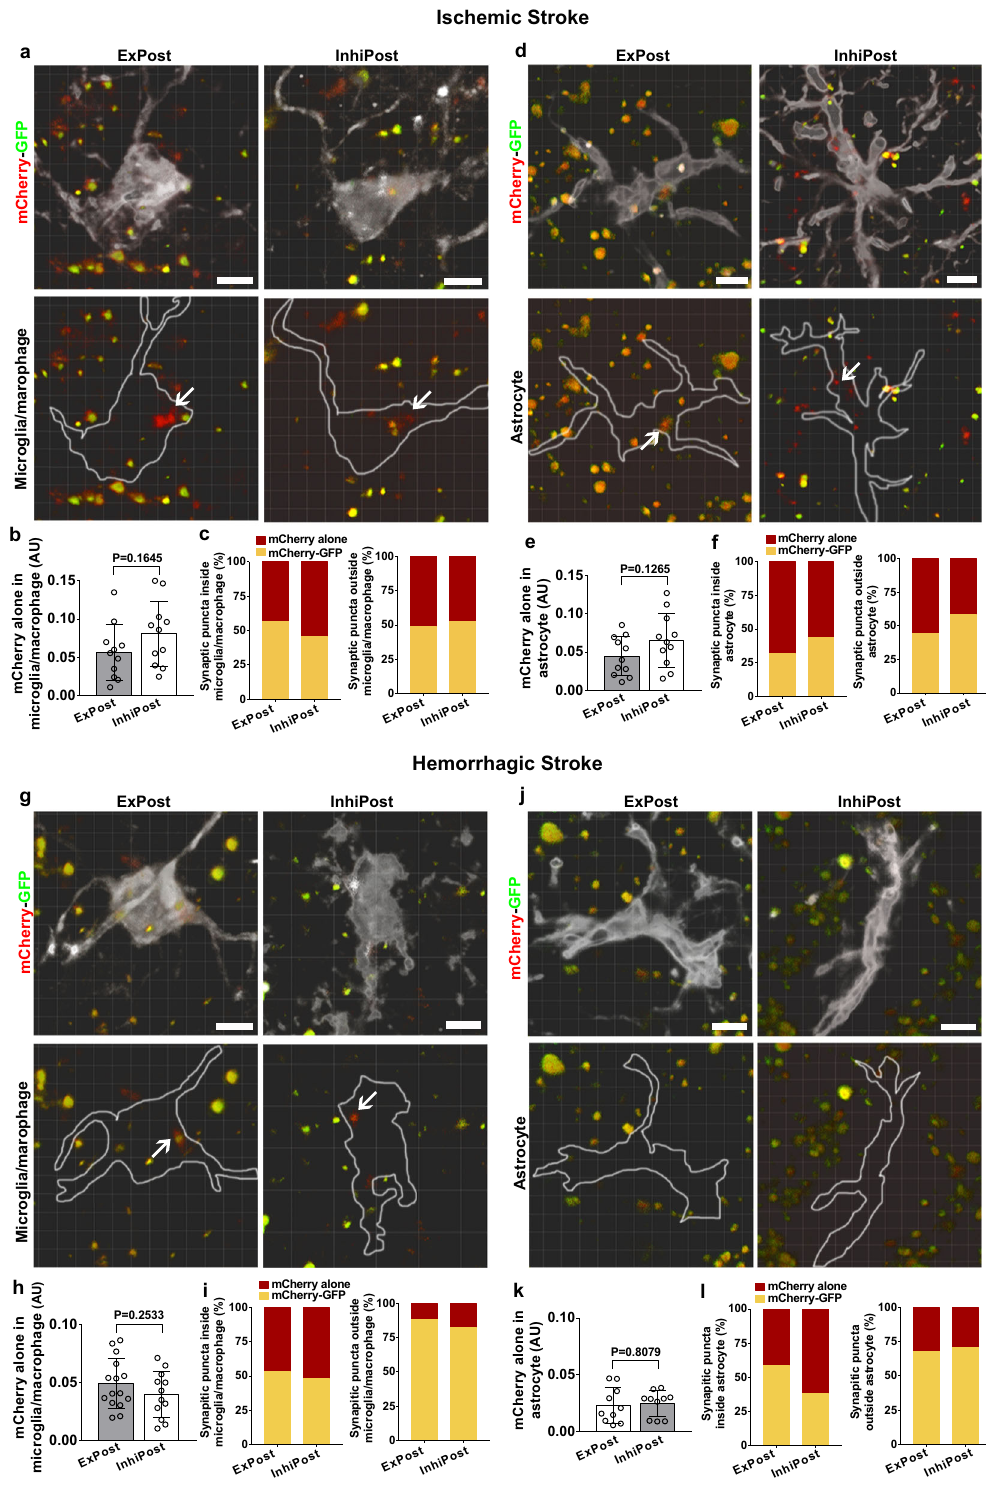
speci fi c MEGF10 KO or MERTK KO mice had elevated levels of SYP and Homer-1. Similarly, 14 days after hemorrhagic stroke, microglia/macrophage-speci fi c MEGF10 KO or MERTK KO mice also exhibited fewer Homer-1 + and SYP + synaptic puncta in microglia/macrophages than control mice (Fig. 5l, m). Condi- tional MEGF10 KO or MERTK KO in astrocytes did not affect the number of synaptic puncta engulfed by astrocytes (Fig. 5n, o). This phenomenon was also detected by western blot,